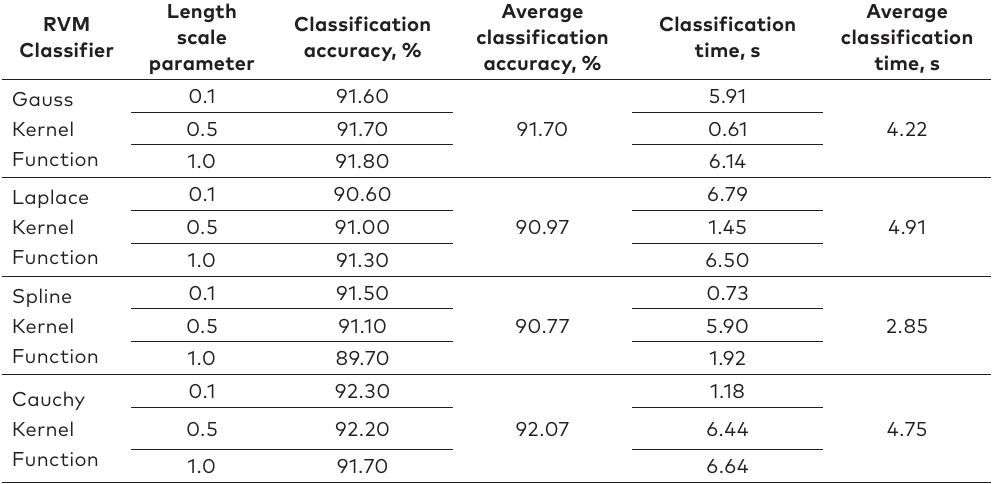
Table 3. Comparison of parameters and classification